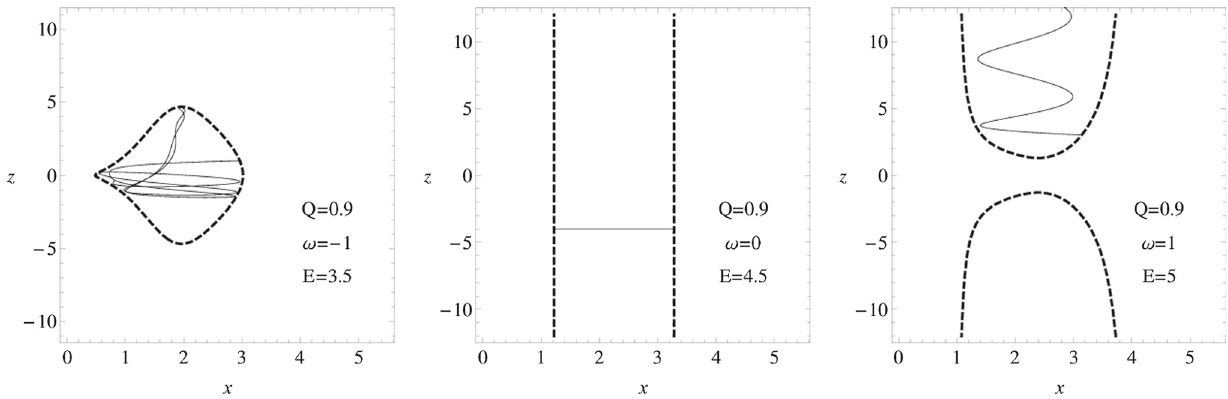
Fig. 2 Energy boundary function E b ( x , z ) for the flat spacetime. We use parameters J = 2 , Q = 0 . 9. For Fig. ω 1 = − 1 we have string energy E = 3 . 5 (left), for ω 1 = 0 E = 4 . 5 (middle) and for ω 1 = 1 E = 5 (right)